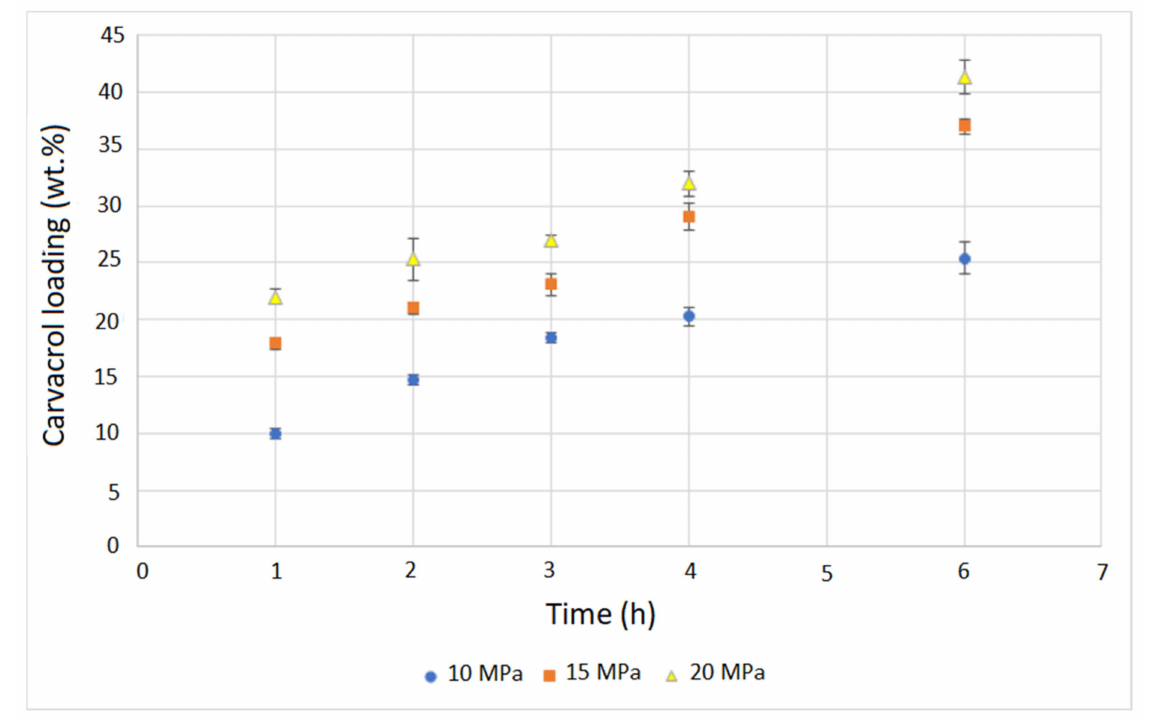
Figure 2. Kinetics of polyamide membranes SSI with